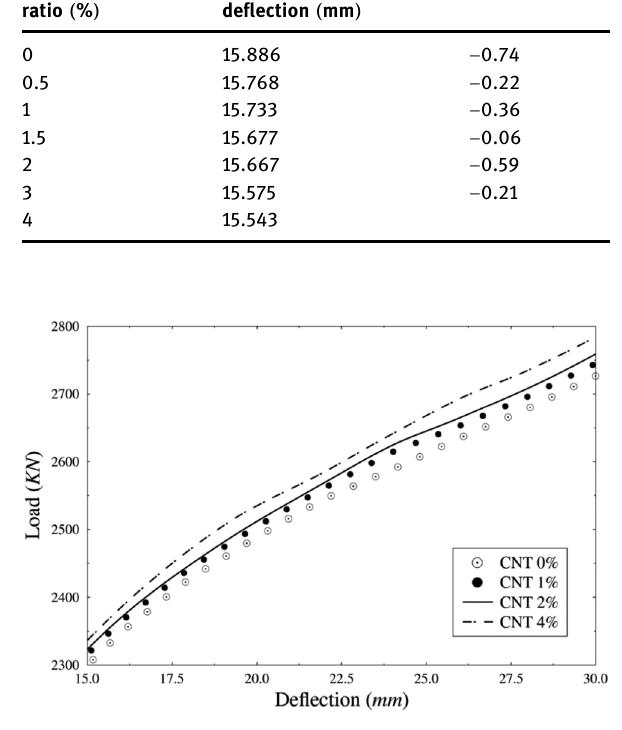
Figure 16: Load – de fl ection curve of the beam with di ff erent CNT weight ratio rebars after the beam cracks.